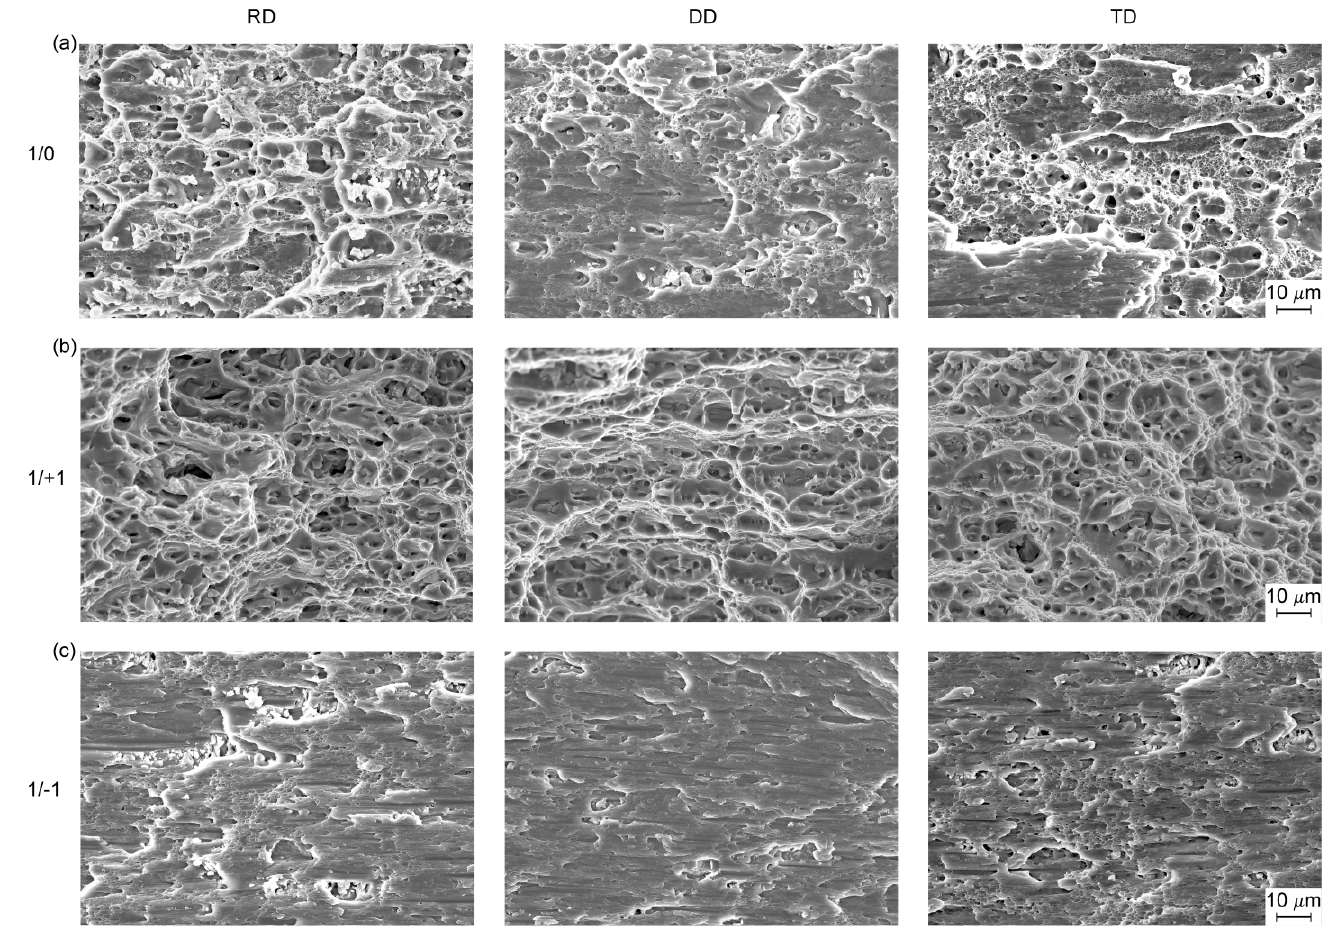
Figure 12. Scanning electron microscopy of fracture surfaces for the load ratios ( a ) F 1 / F 2 = 1/0, ( b ) F 1 / F 2 = 1/+1 and ( c ) F 1 / F 2 = 1/ −